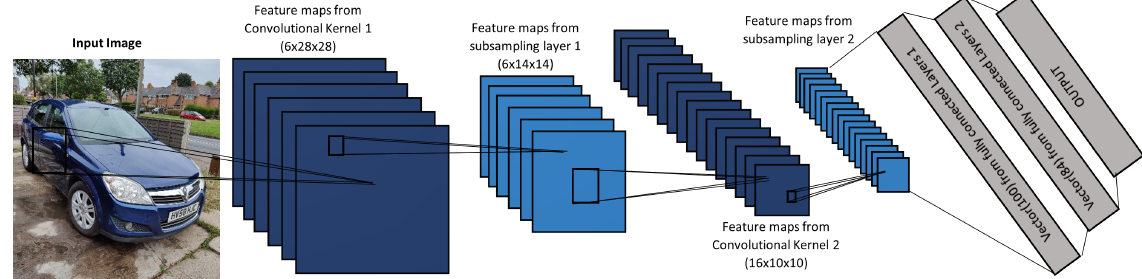
Figure 3. LeNet has seven layers: three convolutional layers, two sub-sampling, and two fully connected layers [52].